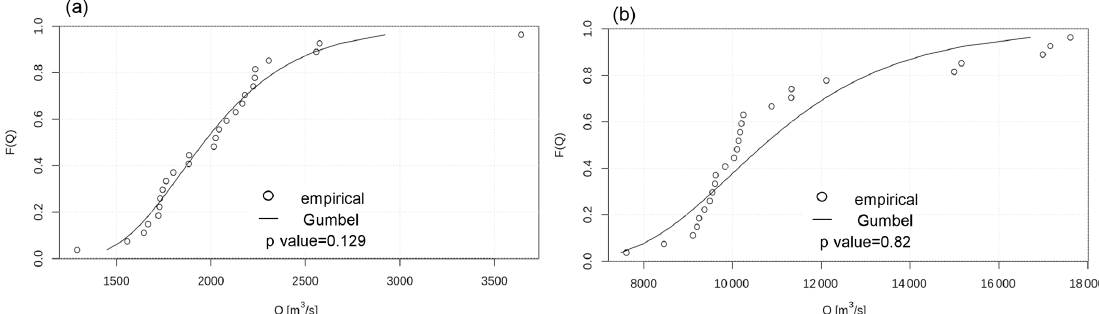
Figure B2. Comparison of the empirical and fitted distributions of annual discharge maxima at selected locations of the rivers Rhine (left) and Danube (right). Table B1. Overview of the hydrological skill of LISFLOOD for the calibration and validation stations. Calibration Validation Calibration NSE No. of